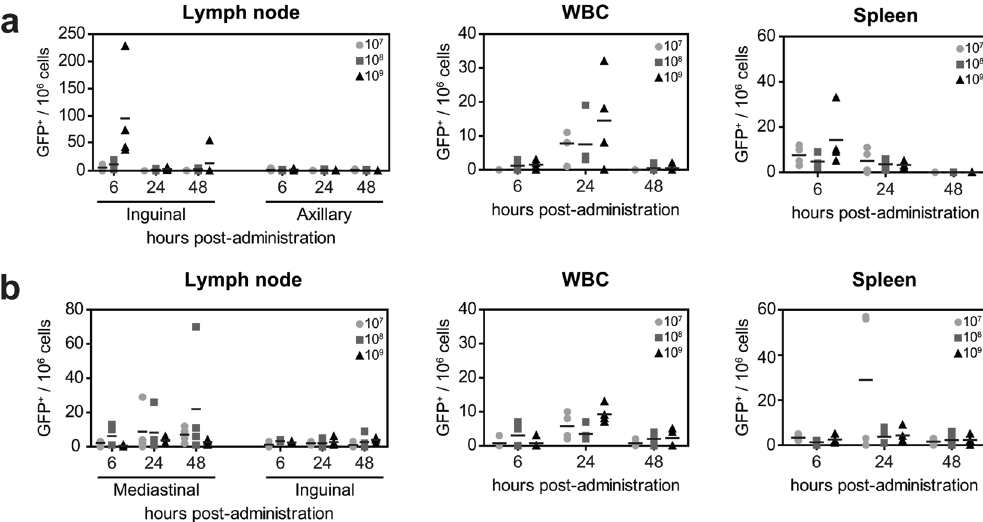
Figure 4. Dissemination of GFP + cells after IM injection or IN instillation of rMVA-GFP to mice. At 6, 24 or 48 HPA of 10 7 , 10 8 or 10 9 PFU rMVA-GFP administration by IM injection ( a ) or IN instillation ( b ), GFP + cells were detected in LN, WBC and spleens using flow cytometry. Number of GFP + cells per 10 6 total cells is shown, mean of four mice is